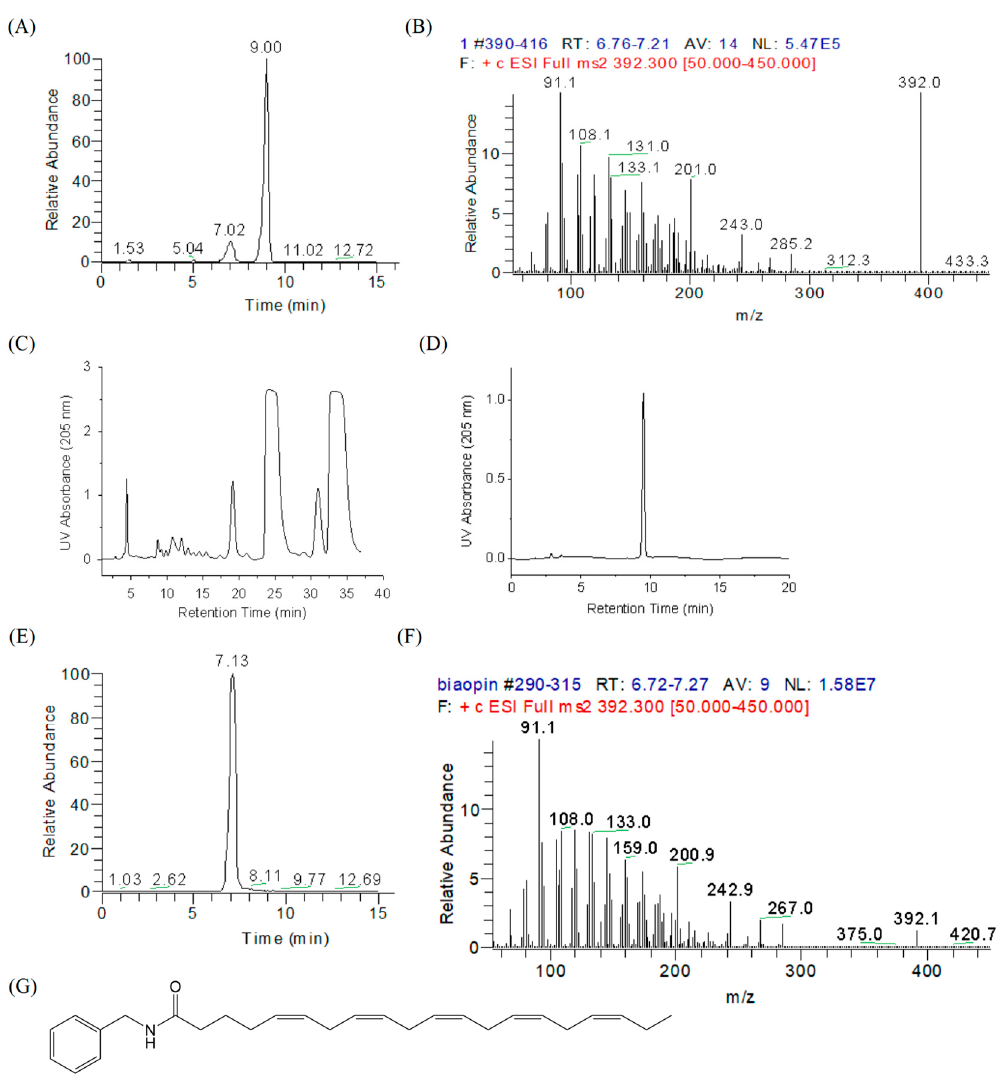
Figure 1. Chromatograms and MS/MS spectra of natural NB-EPA and synthetic NB-EPA. ( A ) Representative total ion current (TIC) chromatogram obtained in positive selected ion monitoring (SIM) mode for a maca extract sample. ( B ) MS/MS spectra of m/z 392.3 ([NB-EPA + H] + ) for the maca extract sample. ( C ) Semi-preparation HPLC chromatogram of synthetic NB-EPA materials. ( D ) HPLC chromatogram of NB-EPA fractions (23.5–25.5 min) collected from a semi-preparation HPLC system. ( E ) Representative TIC chromatogram obtained in positive SIM mode for a synthetic NB-EPA sample. ( F ) MS/MS spectra of m/z 392.3 for the biosynthetic NB-EPA sample. ( G ) Chemical structure of NB-EPA.